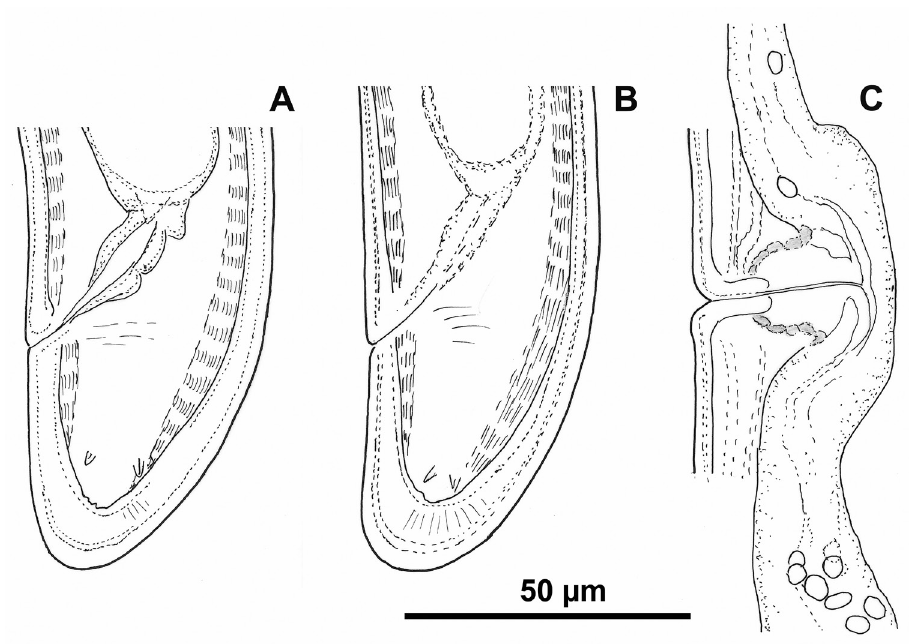
Figure 2. Longidorus piceicola Female from Bran locality: A, B Variations in tail shape C Vagina.